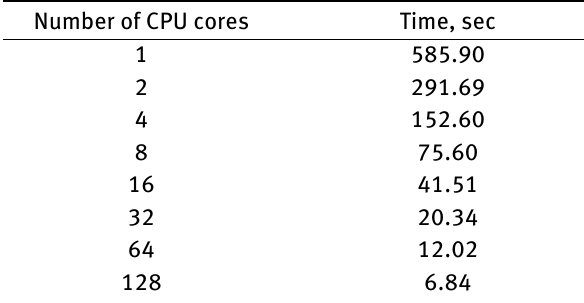
Table 4: Computational times for 16 time-integration steps for the parallel implementation of algorithm for the aggregation and frag- mentation equations with N = 2 22 strongly-coupled nonlinear ODEs. In this benchmark we utilized the nodes from the CPU segment of the cluster.